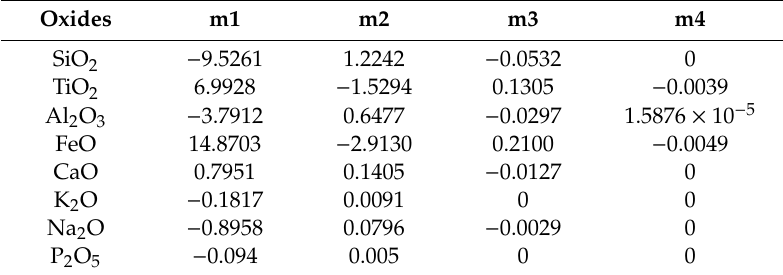
Table 2. Empirical parameters when basalt composition is corrected to MgO =